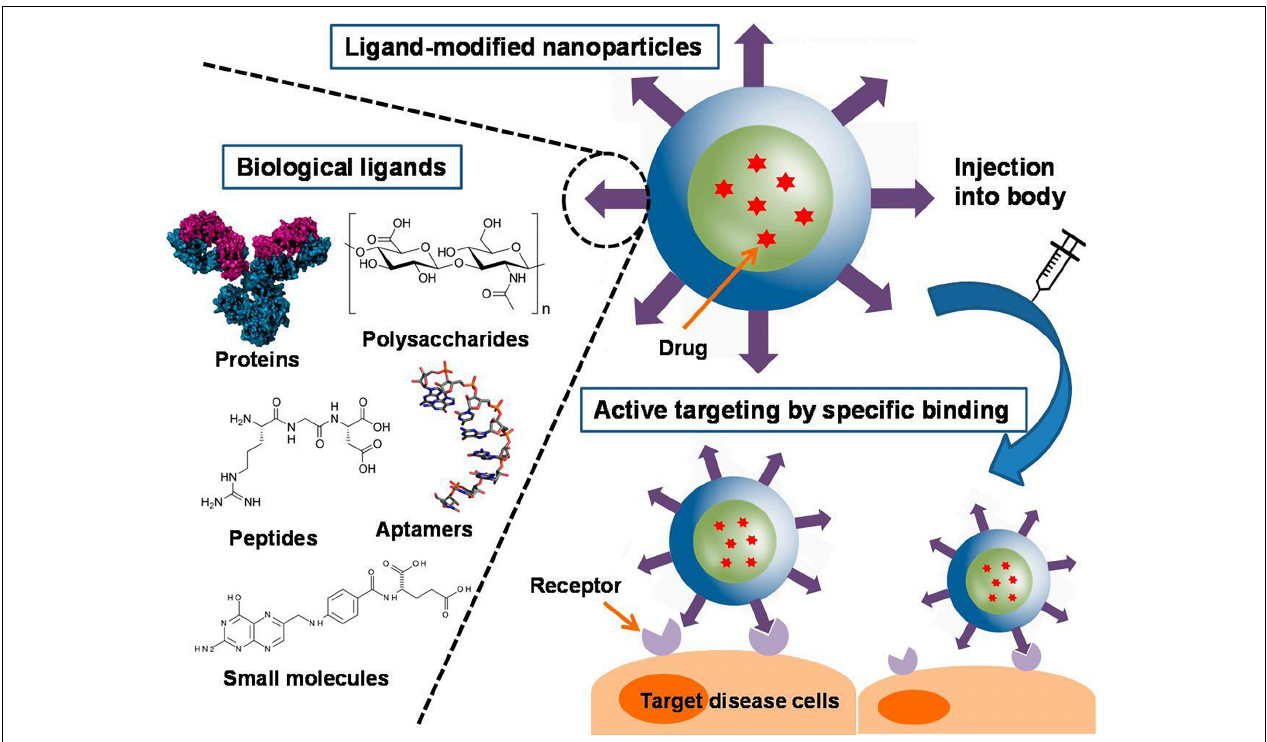
FIGURE 7 | Different types of ligand-conjugated nanoparticles with various active molecules and their targeting mechanisms (Yoo et al., 2019). An increase in ligand density is advantageous for enhanced binding and cellular uptake. A variety of ligands, including proteins, polysaccharides, peptides, aptamers, and small molecules, are employed in functionalized nanoparticles. They can be physically adsorbed or chemically conjugated to the nanoparticles, or they can be tethered to the components of the nanoparticles before formation.